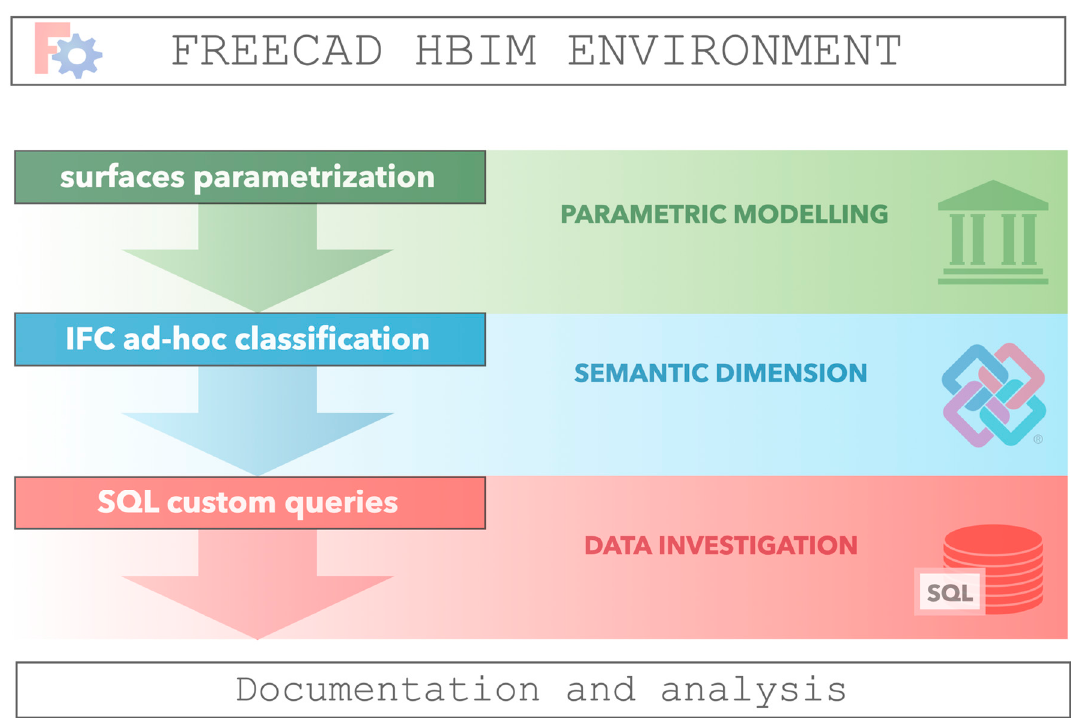
Figure 21. FreeCAD HBIM environment for documentation and analysis: from 3D parametric modeling based on predefined libraries and parametrization of imported surfaces; ad hoc semantic dimension through custom IFC classification and other attributes; ad hoc SQL queries for data investigation.